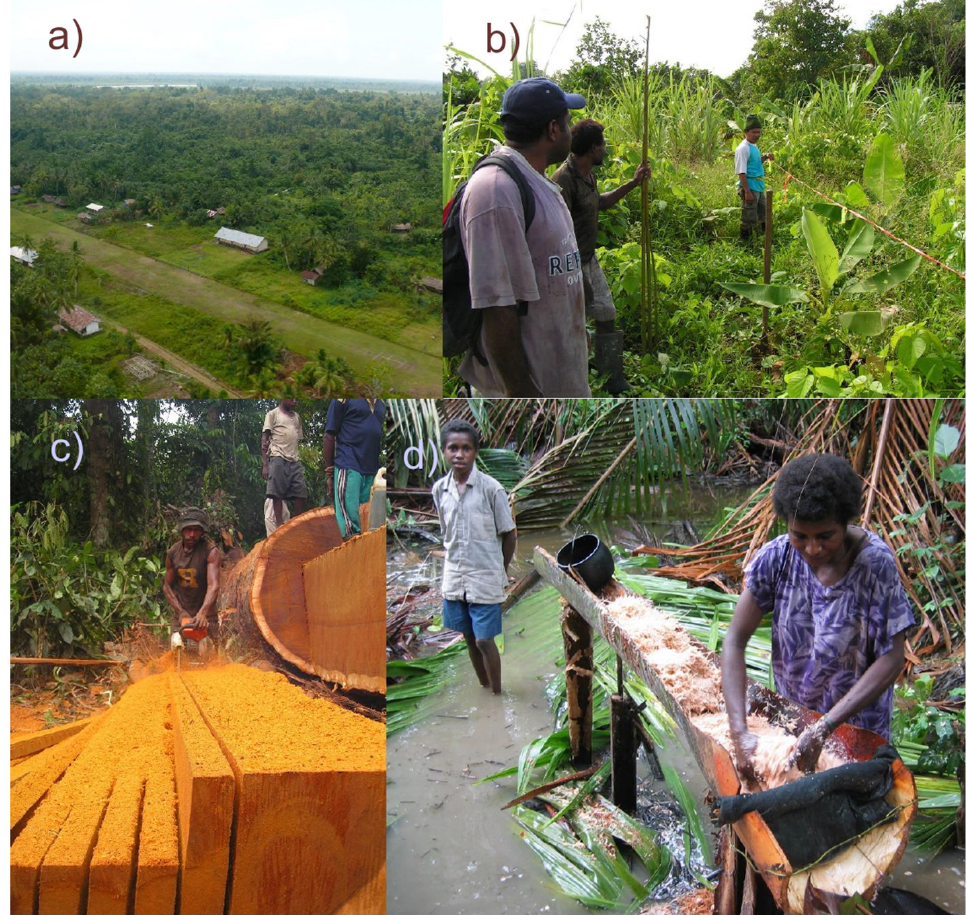
Figure 4. Impacts of human activities are visible around Papasena and its nearby territory as exem- plified by an aerial view of the main settlement ( a ), sampling in a newly opened mixed garden ( b ), timber cutting ( c ), and sago processing within the sago swamp forest ( d ). Credits: MB, DS, DS, and MB.